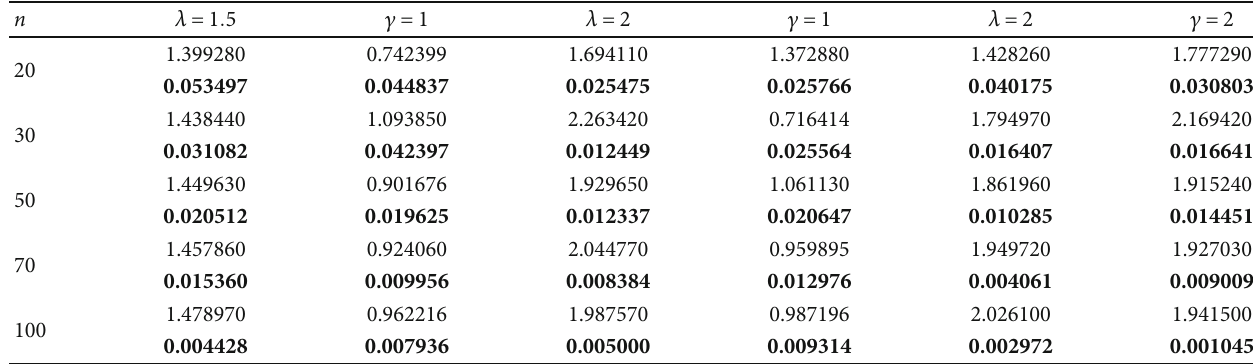
Table 10: BEs and PRs under ELF and informative prior λ = 1 : 5, 2 and γ = 1, 2 .